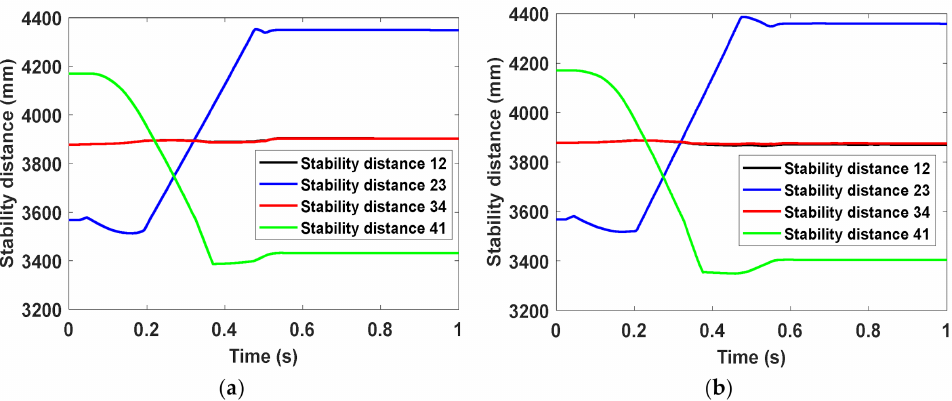
Figure 12. Distances from the center of mass to the stability walls in Case 2 within ( a ) buckypaper and ( b ) aluminum